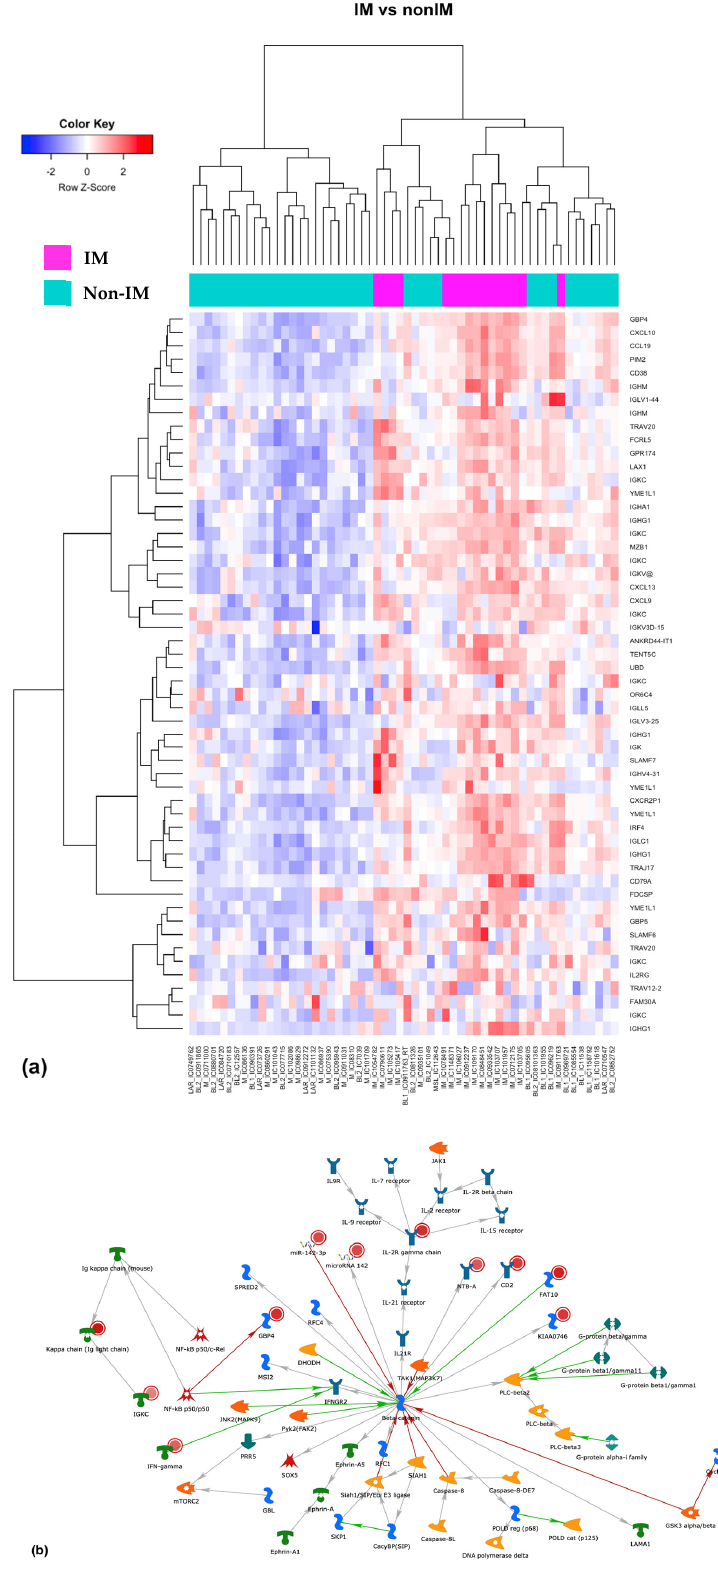
Figure 2. Gene expression analysis ( a ) heat map resulting from an unsupervised hierarchical clustering, the top bar of the heat map shows in magenta the IM samples and in light green the non-IM. Red indicates gene overexpression; columns are samples and rows are genes. ( b ) Enrichment analysis using Metacore Clarivate™ highlighted the β -catenin signaling pathway; red dots mark the genes in our